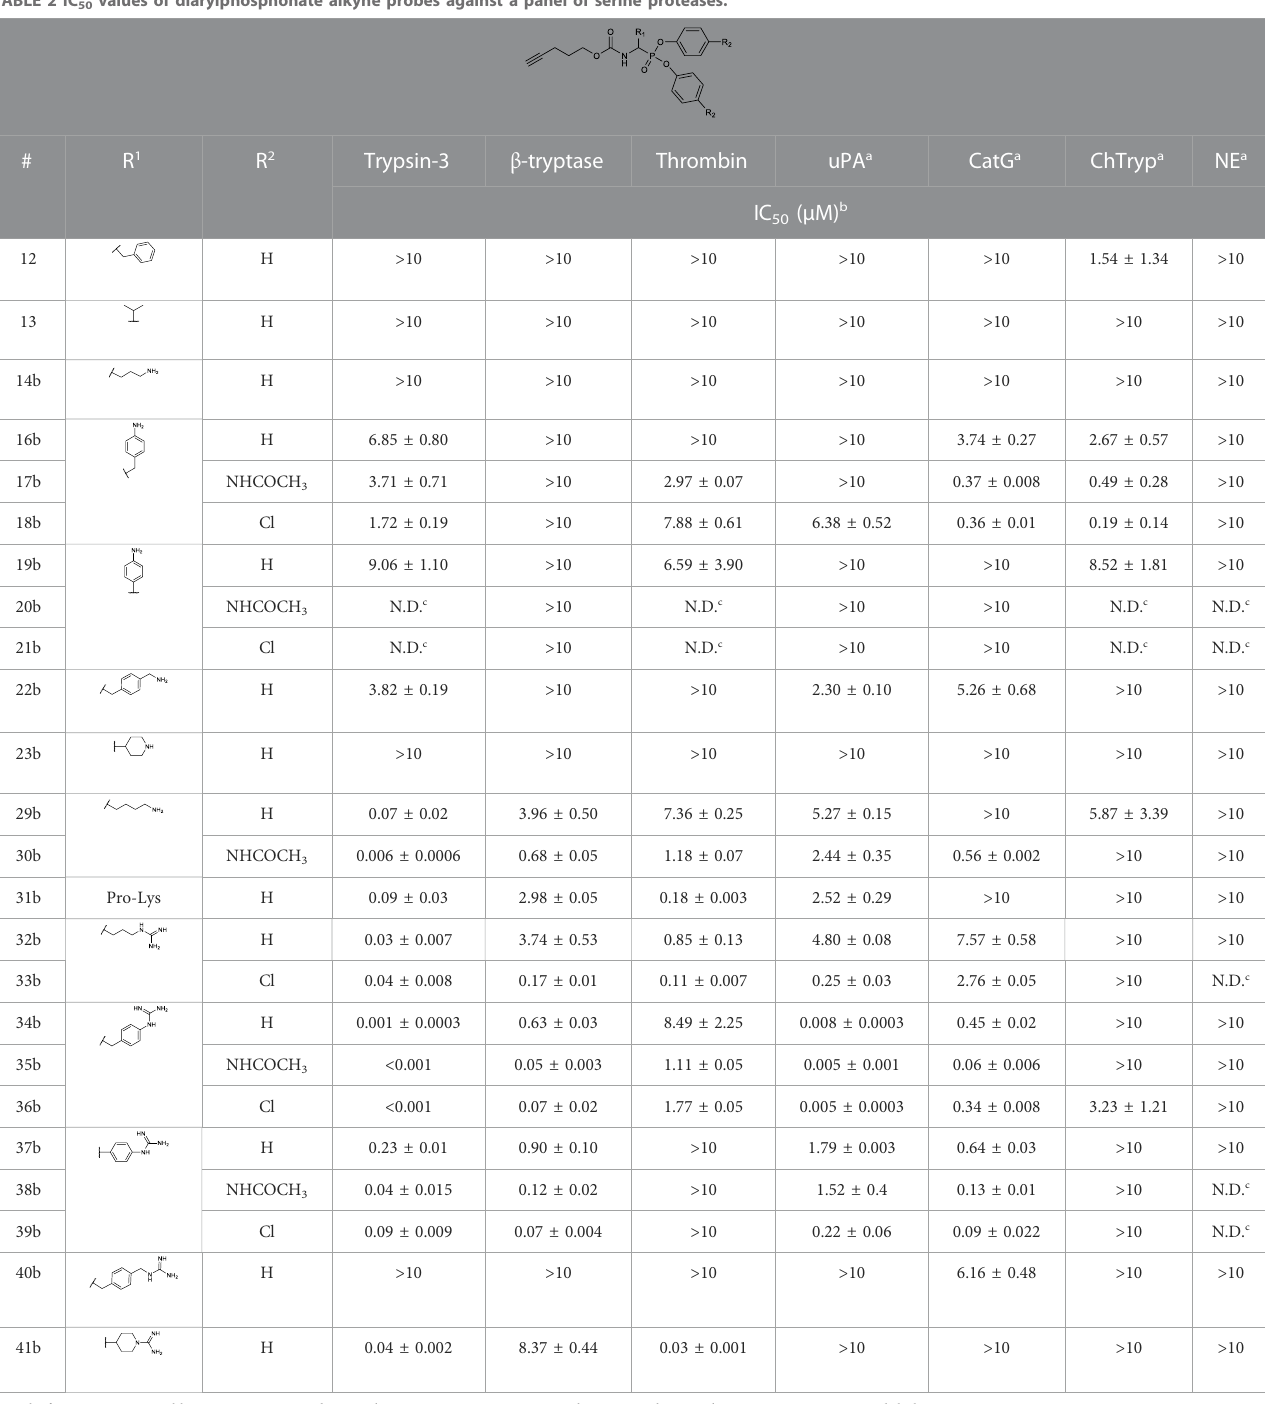
TABLE 2 IC 50 values of diarylphosphonate alkyne probes against a panel of serine